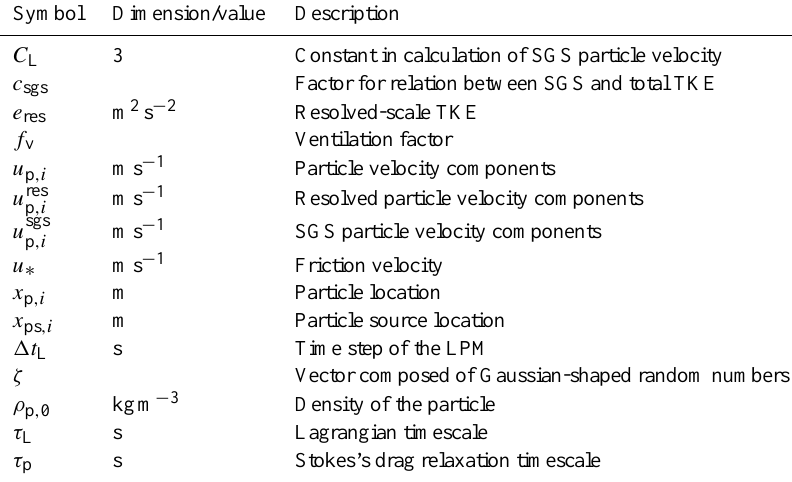
Table 5. List of LPM symbols and parameters. Symbol